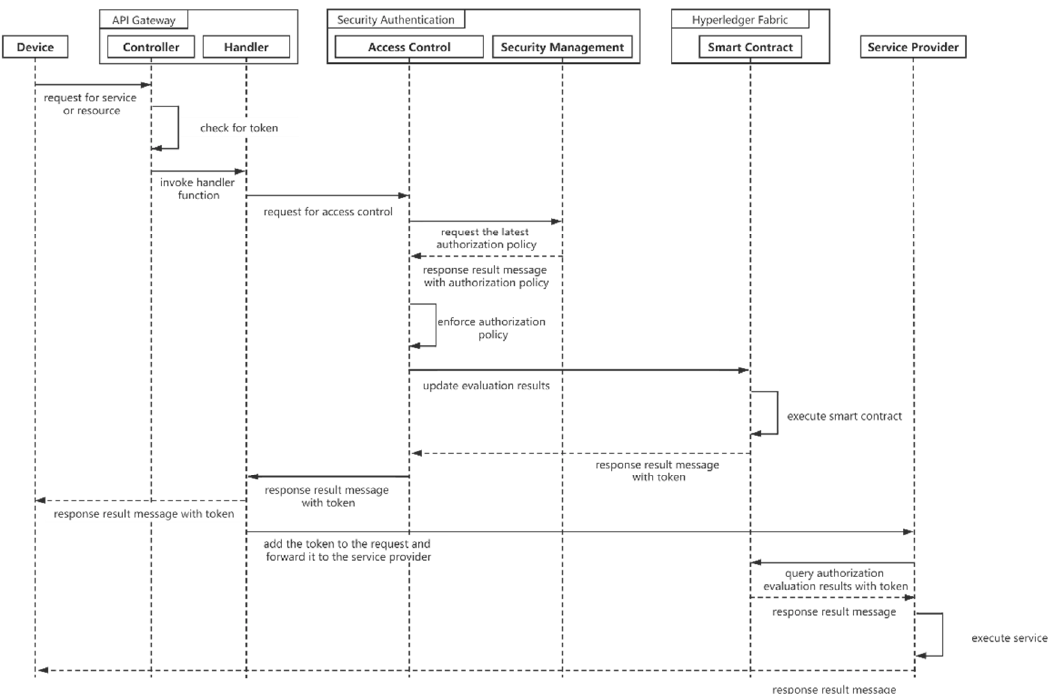
Figure 5. Sequence diagram for access request.